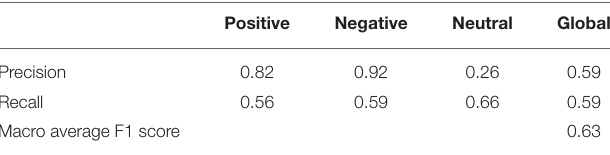
TABLE 3 | Evaluating the performance of NLTK sentiment analyzer on the sentiment of four classes against the labels derived from